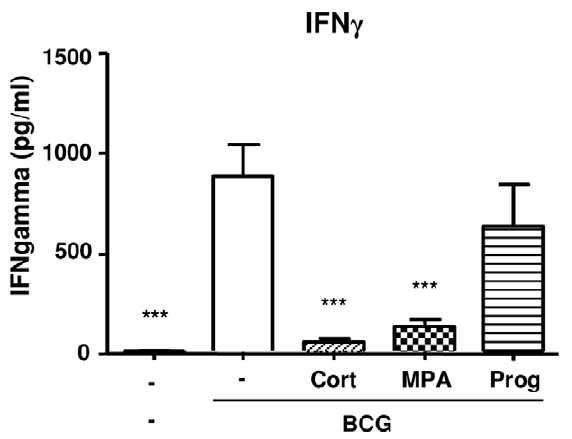
Figure 1. The effect of cortisol (cort), medroxyprogesterone acetate (MPA) and progesterone (prog) on BCG induced IFN c responses of PBMCs of non-contraceptive users. PBMCs of household contacts of active TB cases were cultured with AIM-V medium only (unstimulated controls), incubated with cort, MPA and prog alone (not shown) or M.bovis BCG (5 6 10 5 CFU/ml) in the presence and absence of the three hormones (final concentration of 10 2 5 M). IFN c concentrations were measured by ELISA in the supernatants collected three days post stimulation (n=29). Differences among stimulations were determined by one-way ANOVA with the Bonferroni Post-Hoc test and the data represented as mean 6 SEM. * p , 0.05, **p , 0.01, ***p , 0.001 compared to BCG